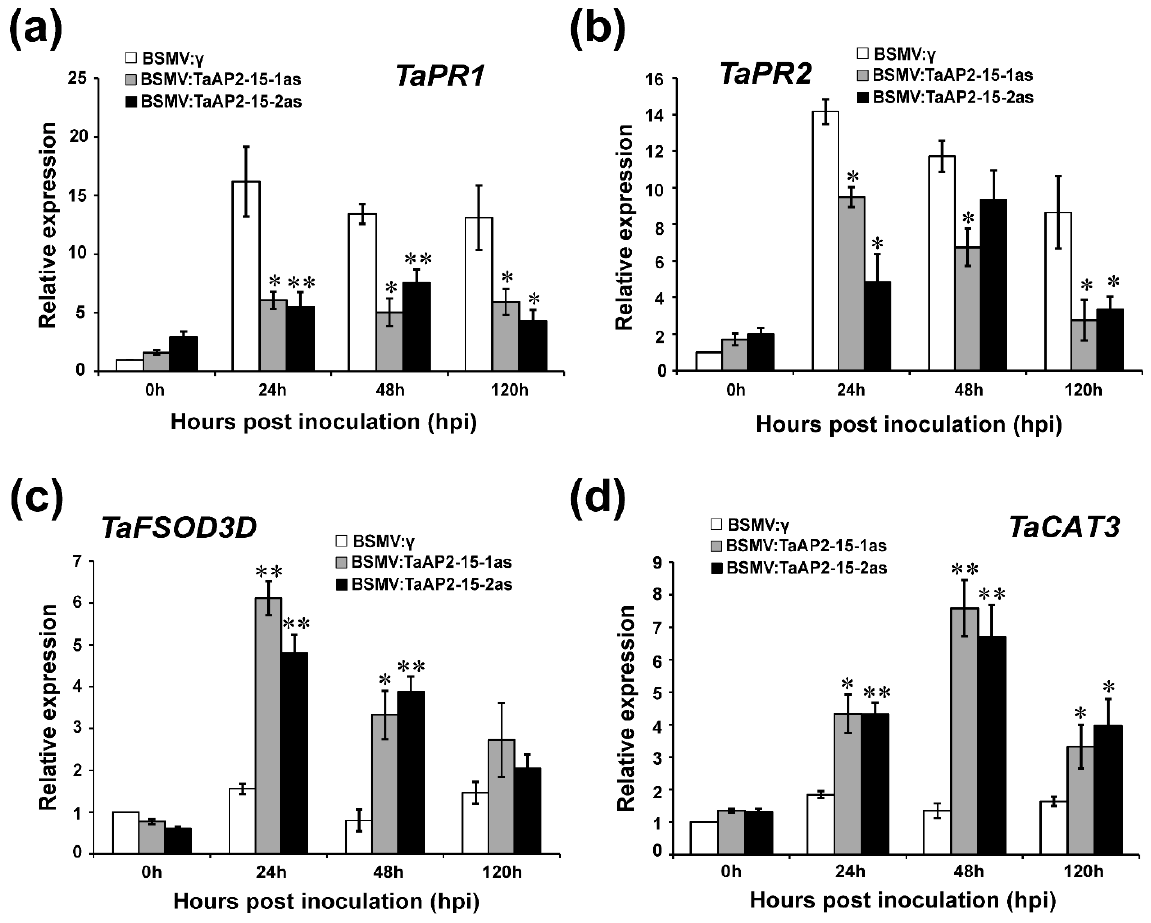
Figure 5. Relative expression of pathogenesis related (PR) and ROS-scavenging genes in TaAP2-15 - silenced and control plants challenged with avirulent Pst race CYR23. The relative transcript levels of: ( a ) TaPR1 , ( b ) TaPR2 ( β -1,3-glucanase) ( c ) TaFSOD3D and; ( d ) TaCAT3 (catalase) were computed by qRT-PCR. Relative expression of these genes was computed by the comparative threshold (2 −ΔΔ C t ) method. The transcript levels of these genes were quantified by qRT-PCR and the data were normalized with the transcripts of the reference gene, TaEF-1 α and expressed as fold changes relative to the control (BSMV: γ ) at 0 h. Data obtained from control plants (BSMV: γ ) after Pst inoculation at 0 h were normalized as 1. Significant differences between TaAP2-15 -knockdown and control plants determined by Student’s t -test are indicated by asterisks. *, p < 0.05, **, p < 0.01. All data were obtained from three biological replicas.